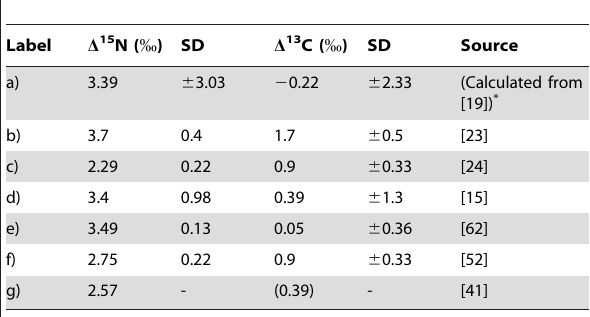
Table 1. Diet-Tissue Discrimination Factors from the